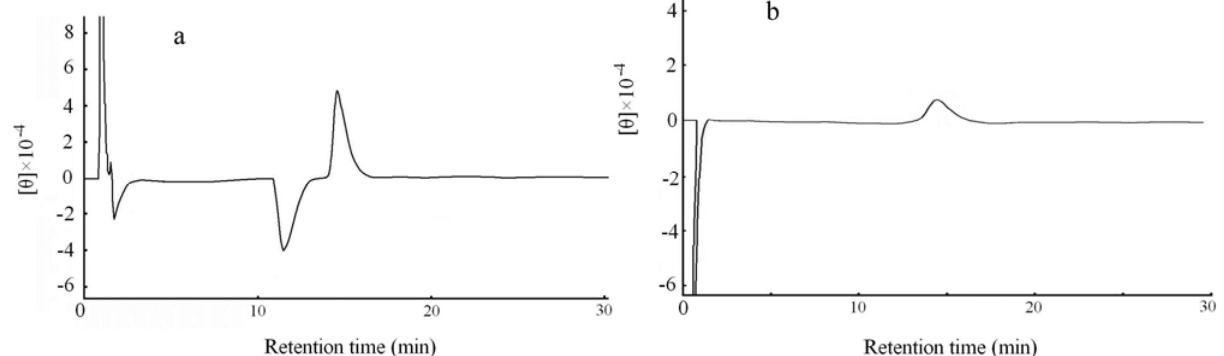
Figure 4. Detection of the reactant product with CD detector. (a) D , L -tryptophan as a standard substance was eluted onto a resolution column Crownpack CR (+). (b) The tryptophan synthesized was eluted onto the same column. Optical isomeric form of the tryptophan was established to be L